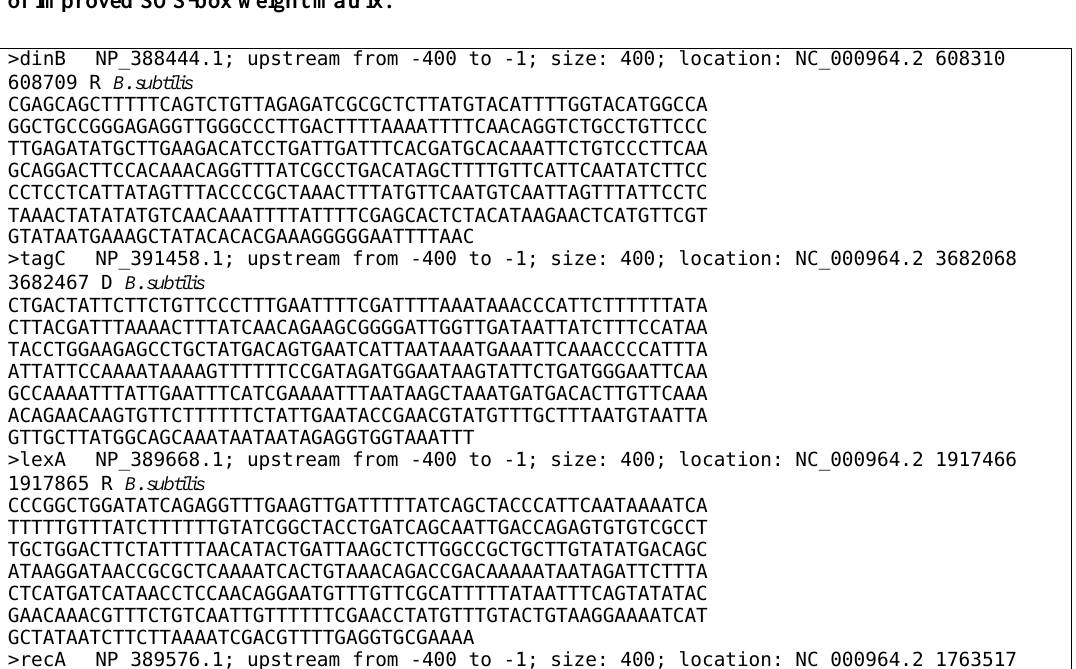
Supplementary Table 2 (S2): Upstream sequences of example data set genes used in the construction of improved SOS-box weight